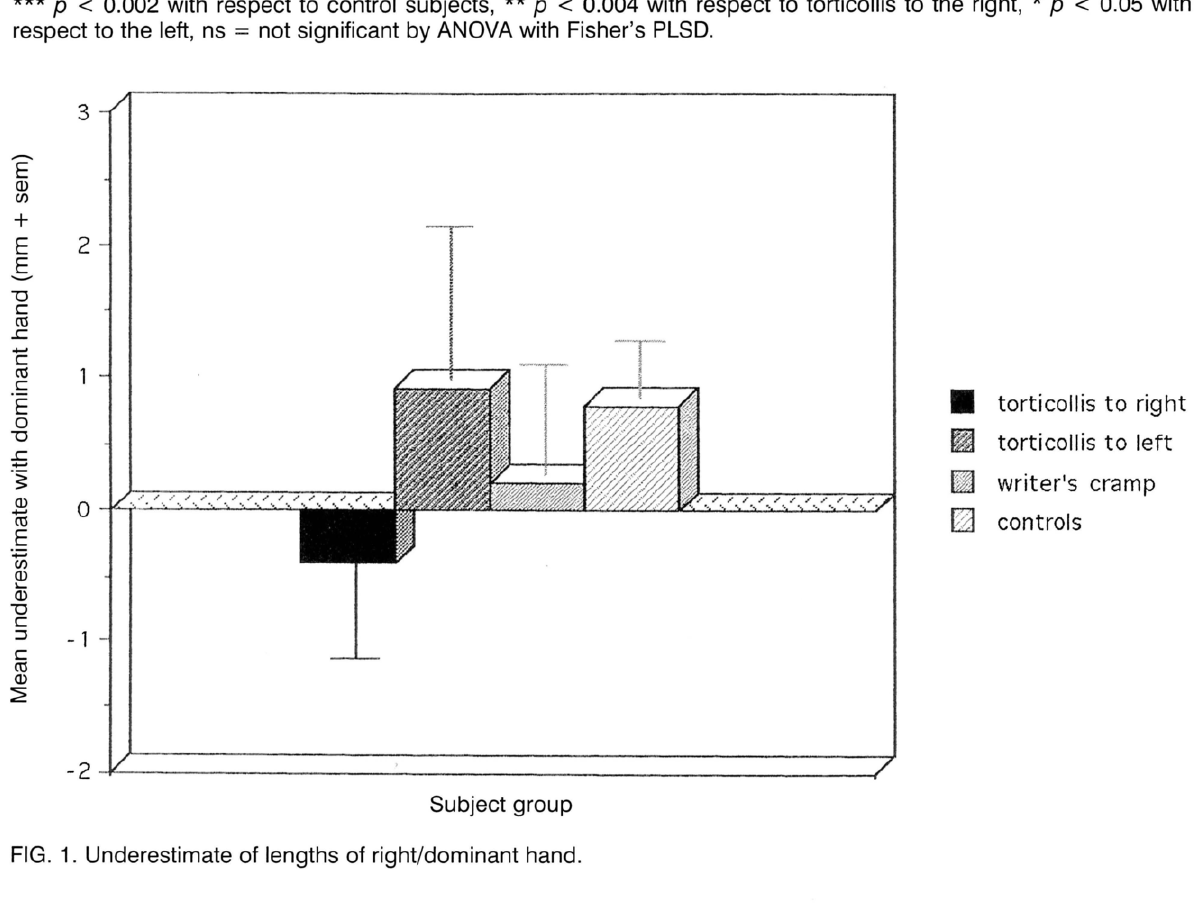
-1.03 g ± 0.34 g), and those with writer's cramp under estimated weights by 0.50 ± 0.42 g when the stimulus was presented to the affected hand (Fig. 2). In six con trol subjects, head position (rotated to right or left) per se did not significantly affect the matching of lengths or weights. The results are shown in Table